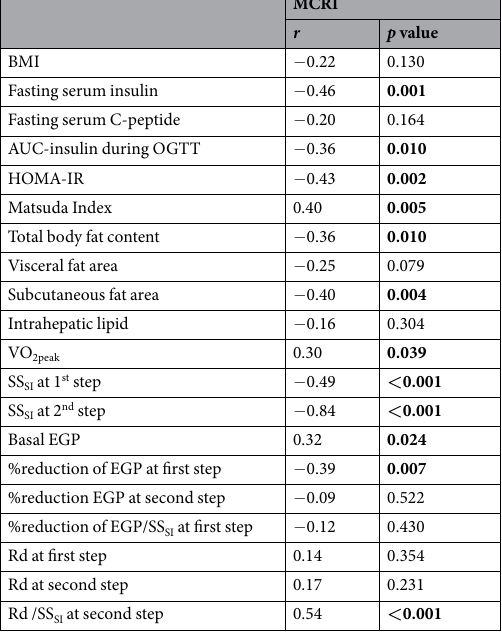
Table 3. Results of univariate regression analysis of MCRI in apparently healthy subjects. HOMA-IR; homeostasis model assessment of insulin resistance, AUC; area under the curve, OGTT; oral glucose tolerance test, VO 2peak ; peak oxygen consumption, EGP; endogenous glucose production, Rd; rate of disappearance, SS SI ; Steady state serum